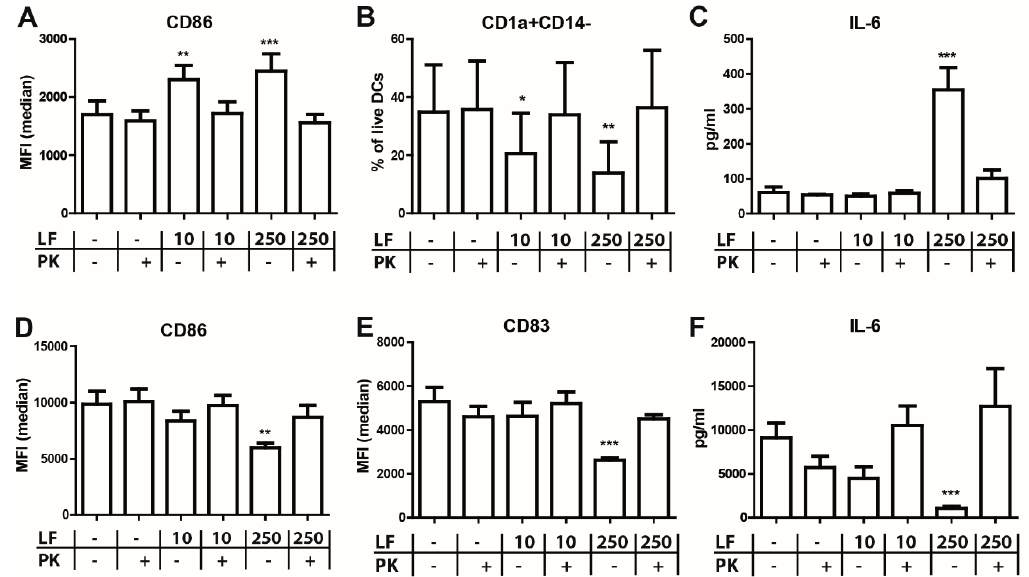
Figure 3. Proteinase K treatment of LF restores responsiveness towards LPS. ( A – C ) monocytes were cultured in the presence of IL-4 and GM-CSF with or without LF or proteinase K treated LF. ( D , E ) These immature DC were subsequently stimulated with 1 µg/mL LPS for 48 h. The median fluorescent intensity (MFI) of ( A , D ) CD86 and (E) CD83 and ( B ) the percentage CD1a+CD14 − DC was shown. ( C , F ) The production IL-6 was measured in the supernatant by CBA. The mean ± SEM of 3 different donors was shown. Significance is indicated by *** = p < 0.001, ** = p < 0.01 and * = p < 0.05.